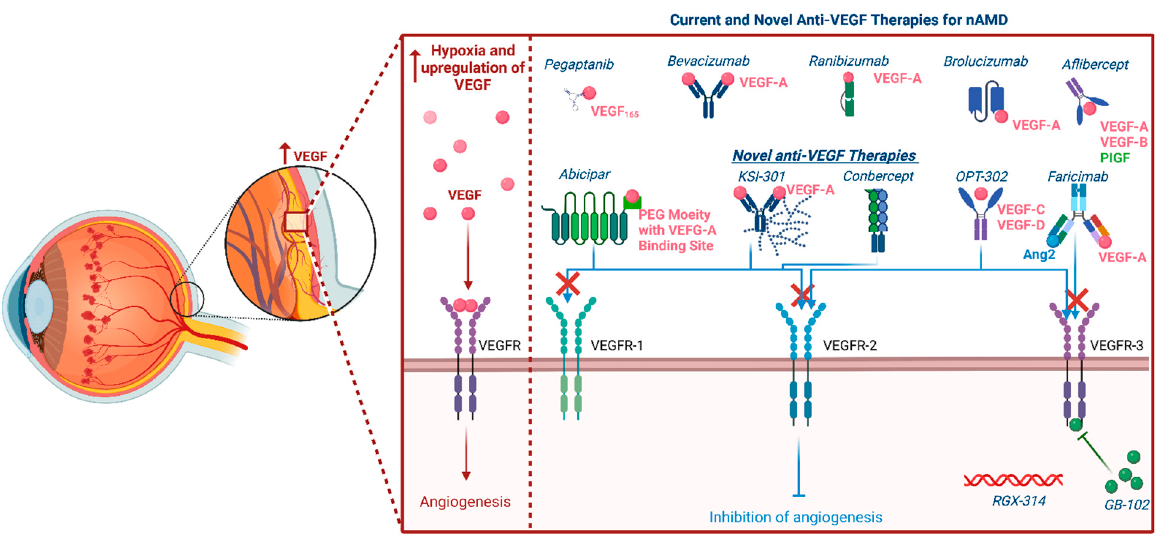
Figure 2. Illustrative diagram summarizing different pharmaceutical modalities for the management of neovascular age-related macular degeneration and their mechanisms of action.